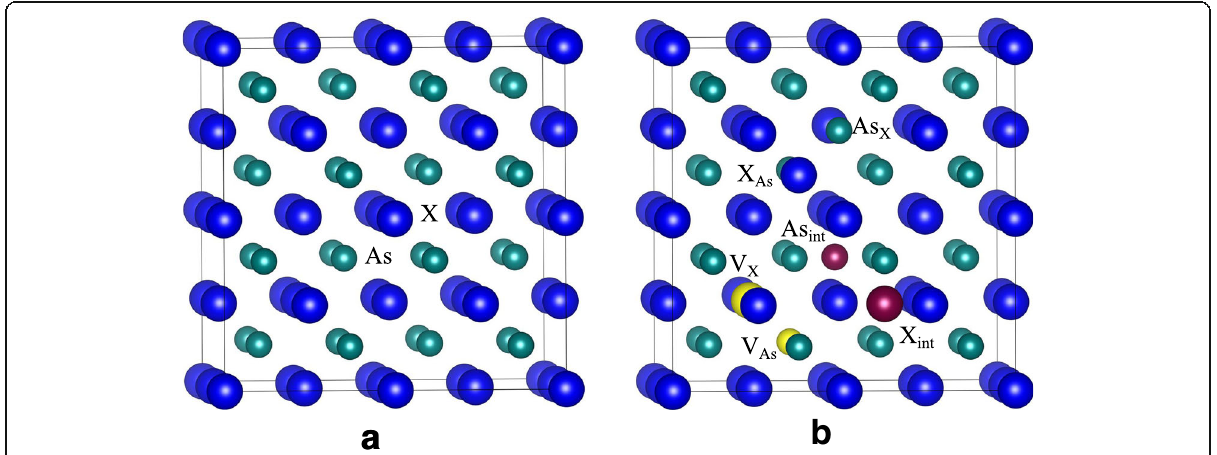
Fig. 1 Schematic view of geometrical structures of a XAs (X = Ga or Al); b the defects in XAs. V X : (X = Ga, Al, or As) X vacancy; X int : X interstitial; As X As : X occupying the As lattice site; X : As occupying the X lattice site. The yellow and purple spheres represent the vacancy and interstitial defects,